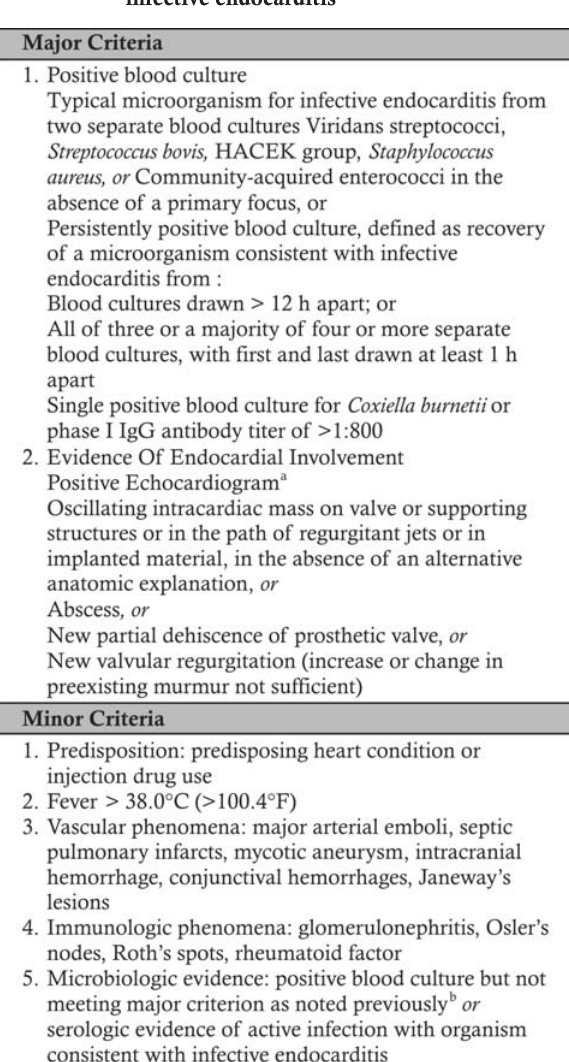
The duke criteria for the clinical diagnosis of infective endocarditis